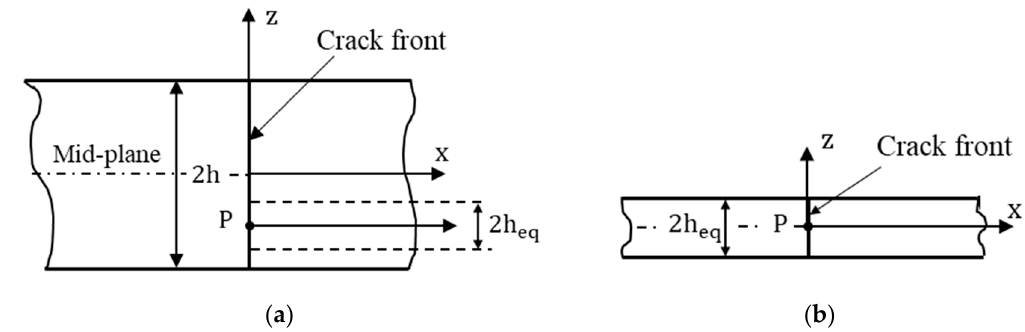
Figure 1. Schematic illustration of the equivalent-thickness method in the through-the-thickness cracks: ( a ) original straight through-the-thickness cracked geometry; ( b ) final straight-through-the-thickness cracked geometry with equivalent